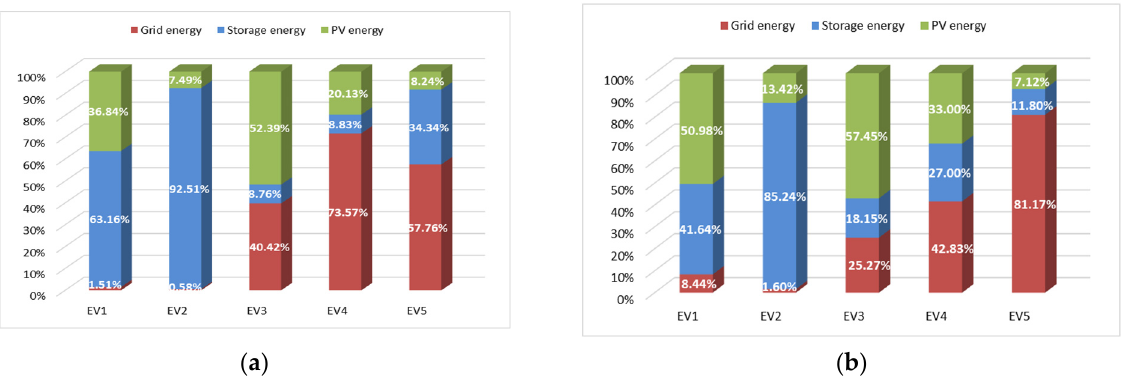
Figure 26. EV energy distribution for “ real-time exp” ( a ) without optimization and ( b ) with optimization—experimental test 2.